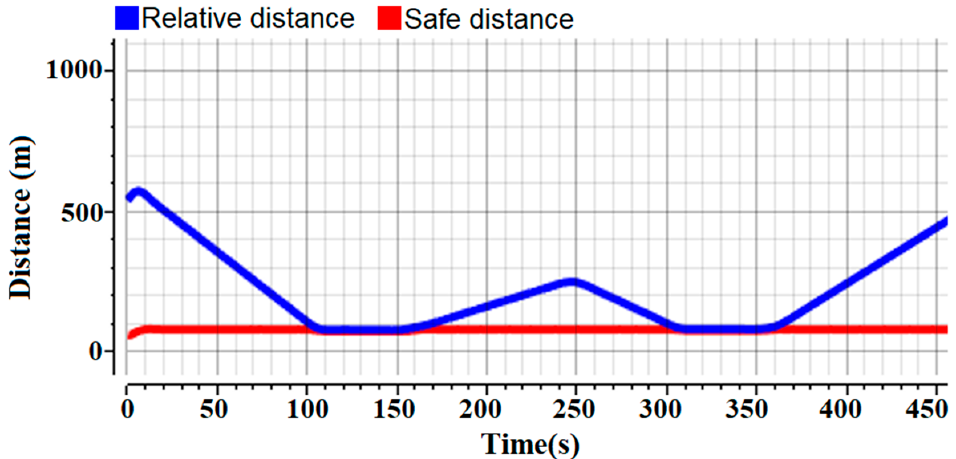
Figure 23. Relative distance and safe distance (experimental results).